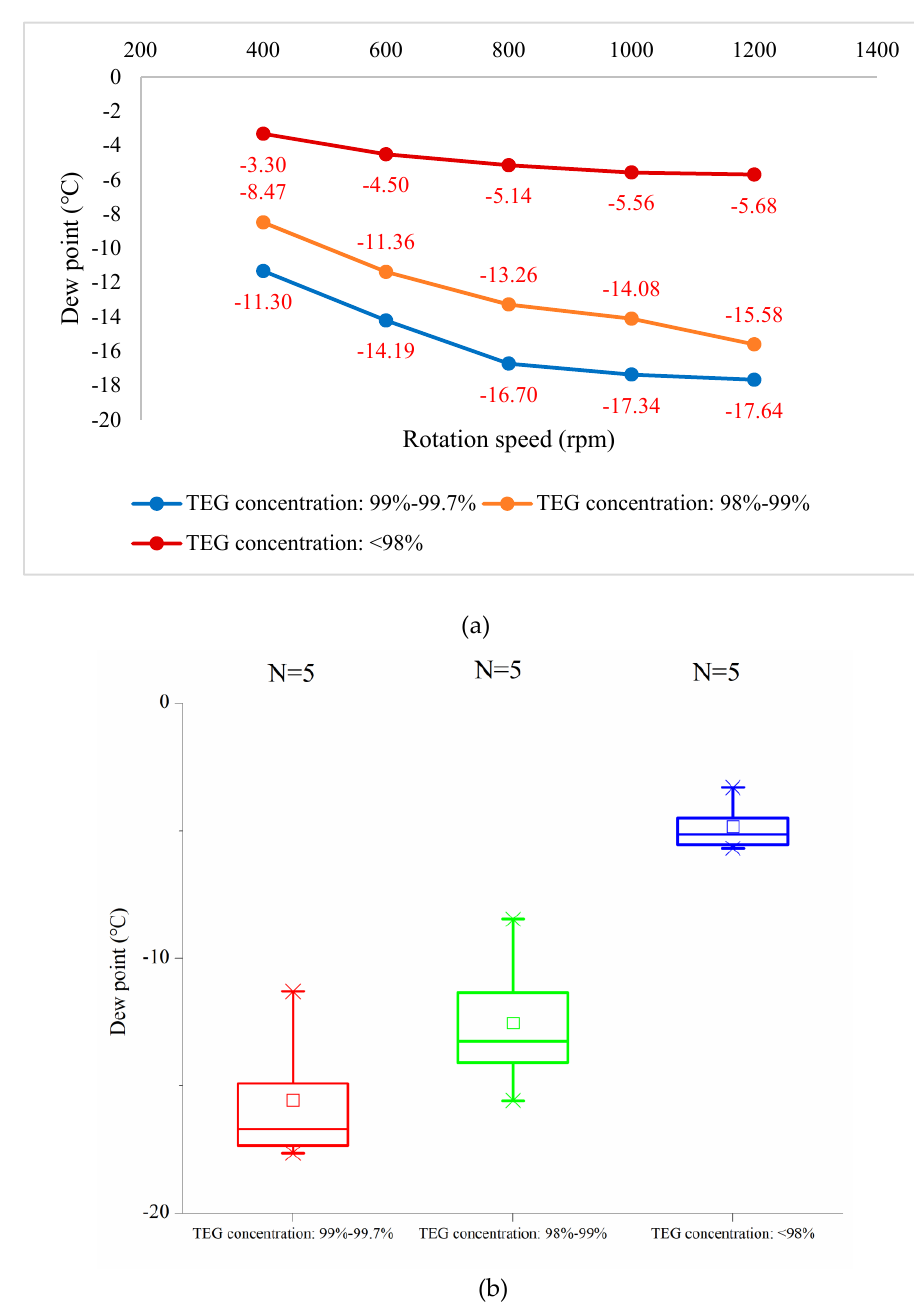
Figure 6. Effect of rotation speed on dew point. ( a ) Experimental data; ( b ) Box-plot. Figure 6. E ff ect of rotation speed on dew point. ( a ) Experimental data; ( b )